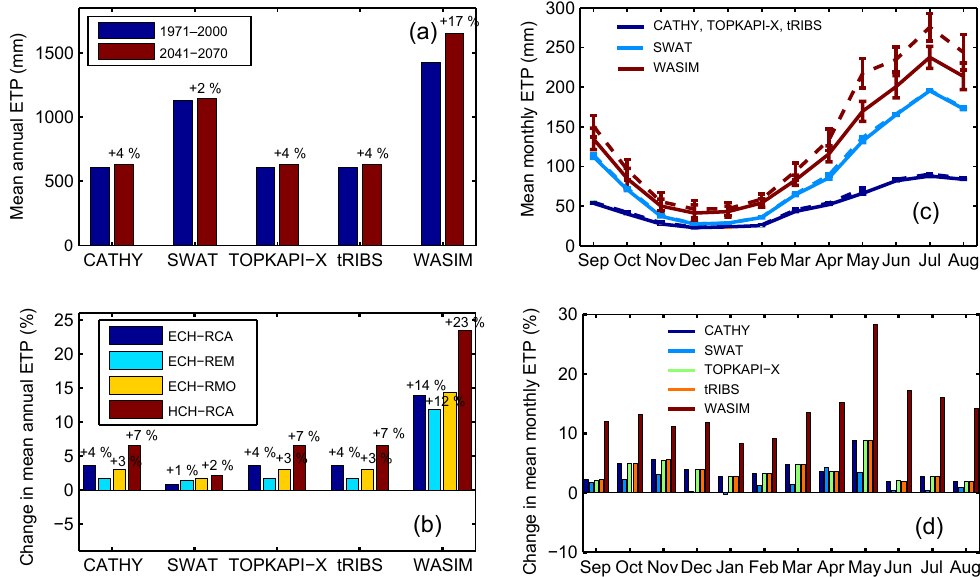
Figure 6. Potential evapotranspiration (ETP) for each hydrologic model forced by the four selected climate models for the reference (REF, 1971–2000) and future (FUT, 2041–2070) periods. (a) Mean annual ETP during REF and FUT periods, obtained as an average among the four climate models. (b) Relative change in mean annual ETP between REF and FUT periods forced by the four climate models. (c) Seasonal distribution of mean monthly ETP during REF (solid line) and FUT (dotted line) periods and corresponding standard deviations (vertical bars), obtained as an average among the four climate models. (d) Seasonal distribution of relative change in mean monthly ETP between REF and FUT periods, obtained as an average among the four climate